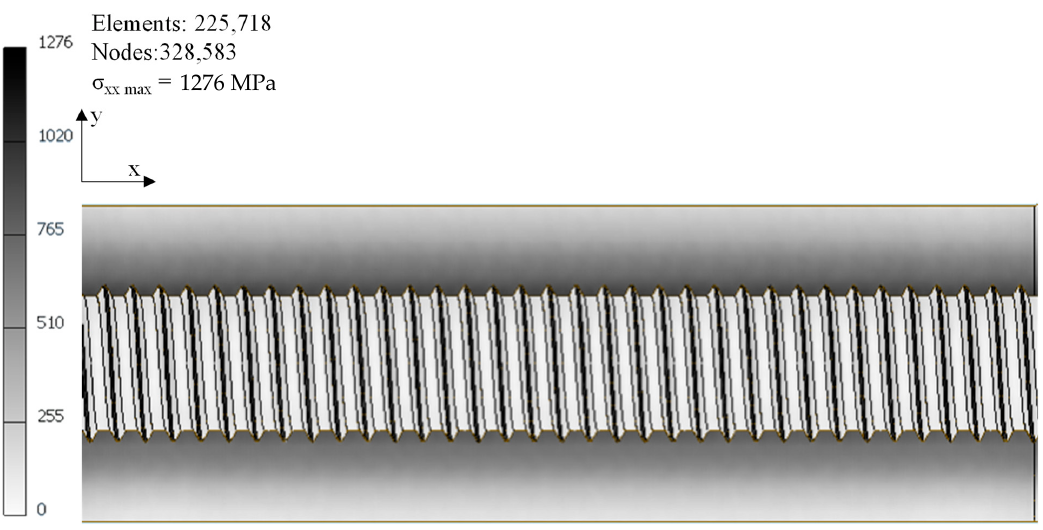
Figure 3. FEM results, σ max = 1276 MPa.